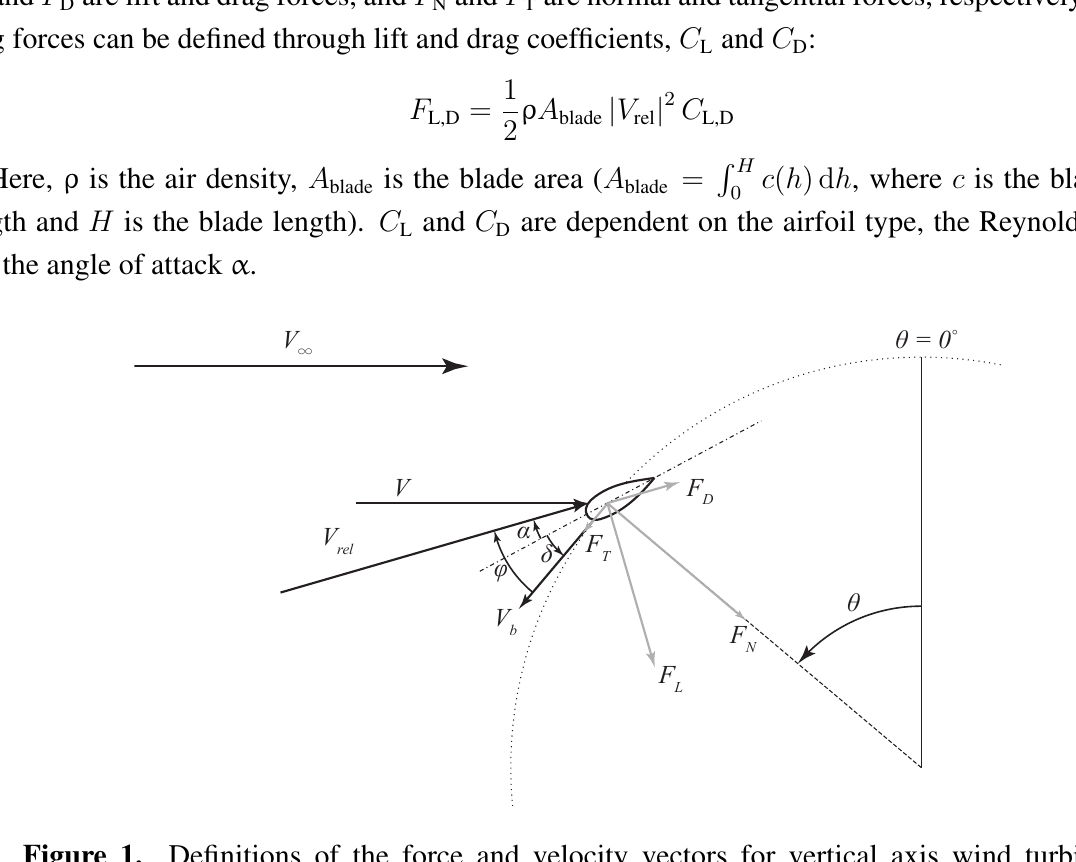
is outwards from the turbine disk, i.e. , F N